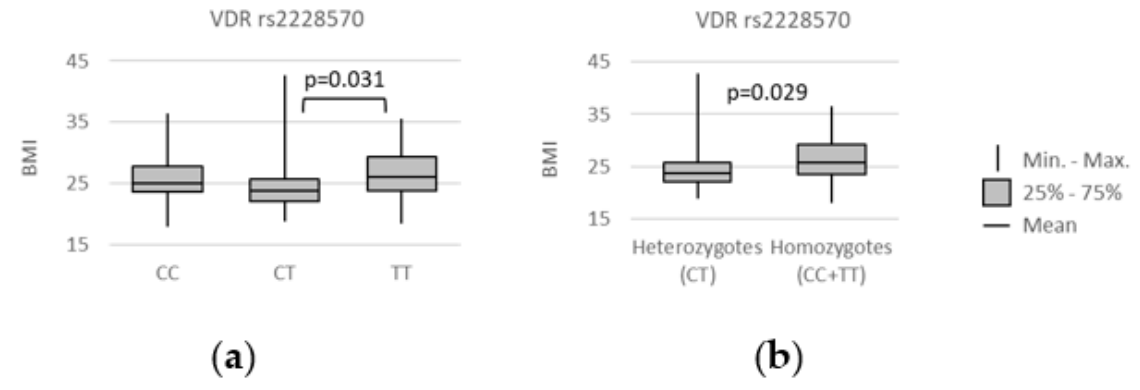
Figure 3. Relationships between VDR rs2228570 genotypes and patients’ body mass index (BMI), measured in kg/m 2 . The following statistically significant associations were found: ( a ) CT vs. TT , p = 0.031; ( b ) CC + TT vs. CT , p = 0.029. Analysis was performed using unpaired two-sample Wilcoxon test.